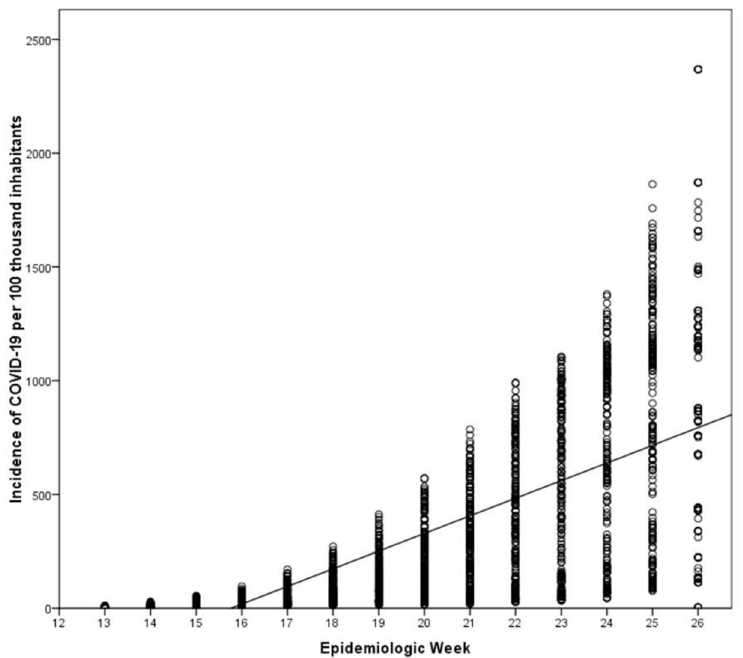
Fig 1. Distribution of the incidence of COVID-19 cases in Brazilian cities up to the 26th epidemiological week. Circles are the observed cases and line is the general trend of progression of the cases.